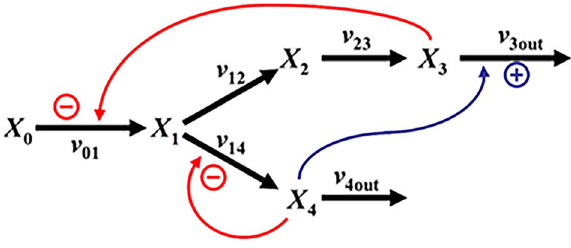
Fig. 3. Generic pathway with one activating and two inhibitory signals. Subscripted X ’s are metabolites, while subscripted v ’s are